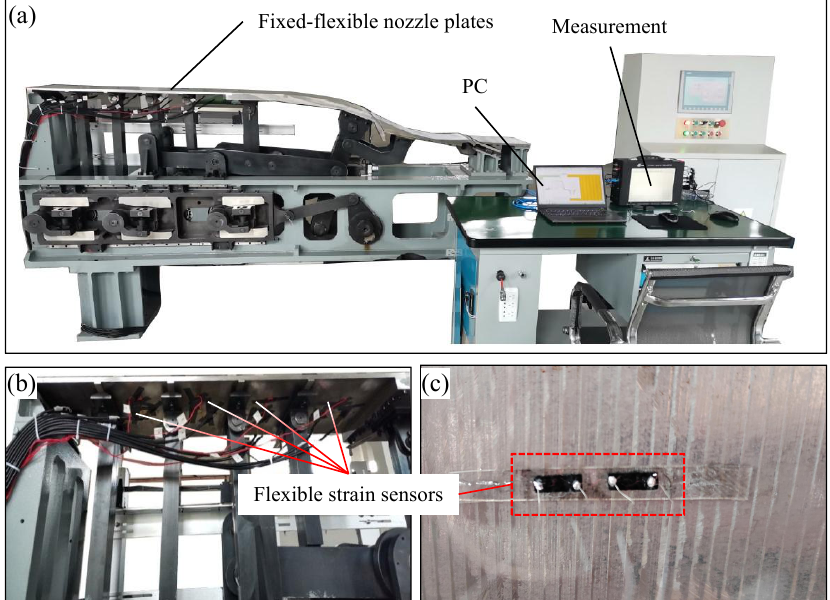
Figure 5. ( a ) The prototype of FFN plate acting as experimental platform. ( b ) The contribution of flexible strain sensors under the plate. ( c ) The flexible strain